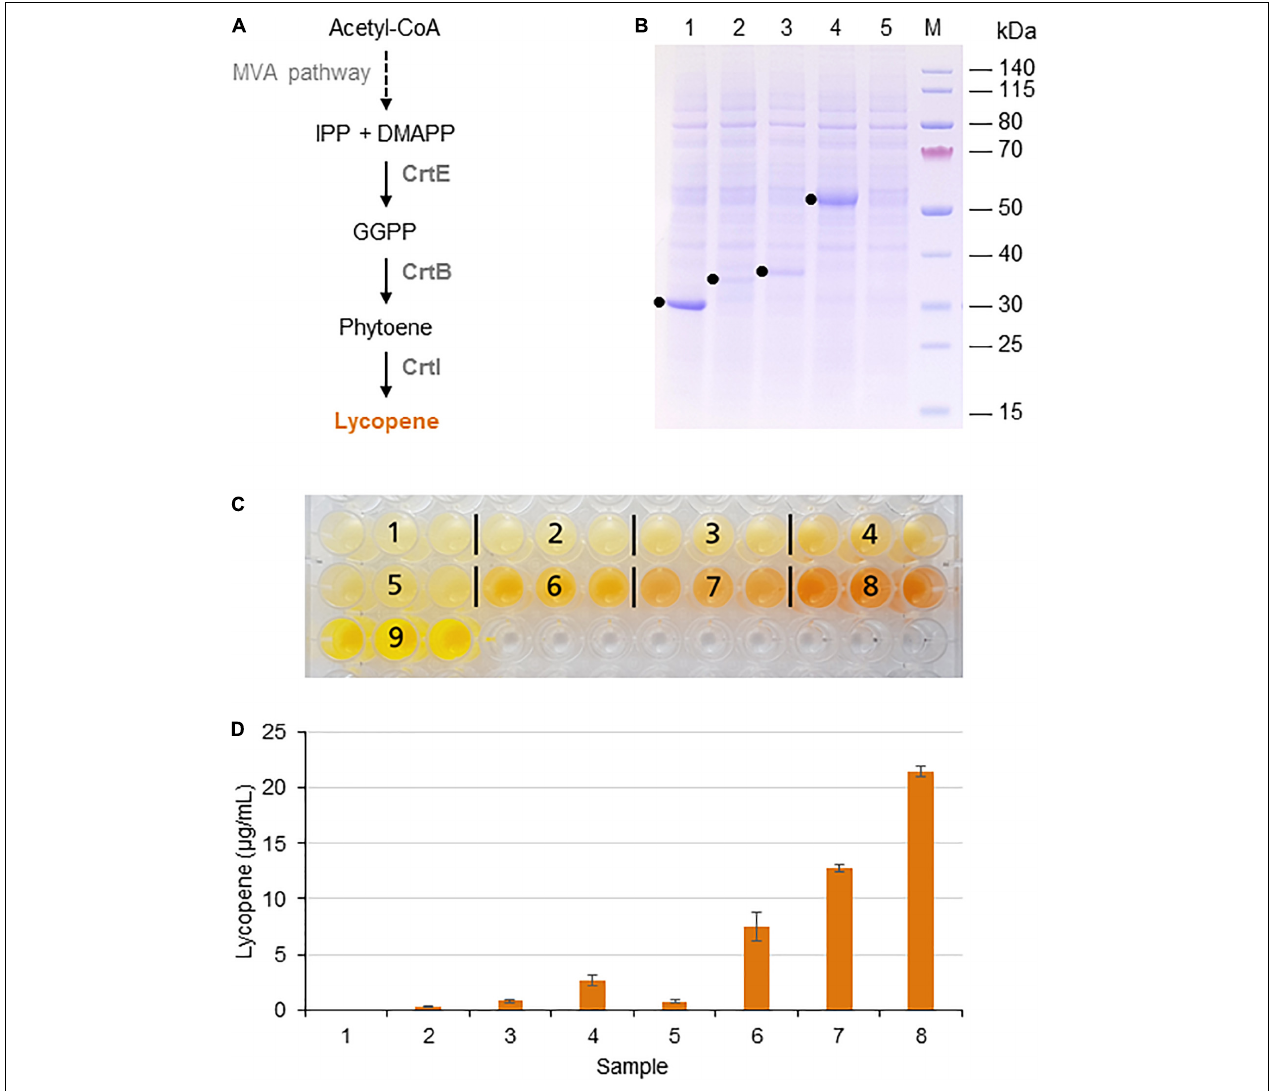
FIGURE 1 | Lycopene biosynthesis in the BY-2 cell-free system. (A) Schematic overview of the endogenous mevalonate (MVA) pathway and the engineered carotenoid biosynthesis pathway in the BYL system. These pathways are localized in the cytosol or the cytosolic fraction of BYLs. Solid arrows represent single enzymatic steps and dashed arrows represent multiple enzymatic steps. The reactions catalyzed by P. ananatis CrtE, CrtB, and CrtI are indicated. IPP, isopentenyl diphosphate; DMAPP, dimethylallyl diphosphate; GGPP, geranylgeranyl diphosphate; CrtE, GGPP synthase; CrtB, phytoene synthase; and CrtI, phytoene desaturase. (B) SDS-PAGE analysis of BYL transcription–translation reactions after 44 h at 25 ◦ C and 70% humidity, shaking at 500 rpm. In each case, 0.5 µ L of the reaction mix was loaded onto a 4–12% (w/v) gradient gel. Lane 1: Strep-eYFP (29 kDa), lane 2: CrtE-Strep (34 kDa), lane 3: CrtB-Strep (36 kDa), lane 4: CrtI-Strep (56 kDa), and lane 5: no template control. (C) Image of the in vitro reactions after incubation for 21 h: (1) no-template control, (2) CrtE, (3) CrtB, (4) CrtI, (5) CrtE + CrtB, (6) CrtB + CrtI, (7) CrtE + CrtI, (8) CrtE + CrtB + CrtI, and (9) Strep-eYFP. (D) Lycopene produced in BYL transcription–translation reactions after incubation for 21 h: (1) no-template control, (2) CrtE, (3) CrtB, (4) CrtI, (5) CrtE + CrtB, (6) CrtB + CrtI, (7) CrtE + CrtI, and (8) CrtE + CrtB + CrtI. After lycopene extraction, the concentration was determined by absorbance spectrophotometry at 472 nm and was compared to a standard curve prepared using commercial lycopene. Data represent the means and standard deviations of three independent transcription–translation experiments.